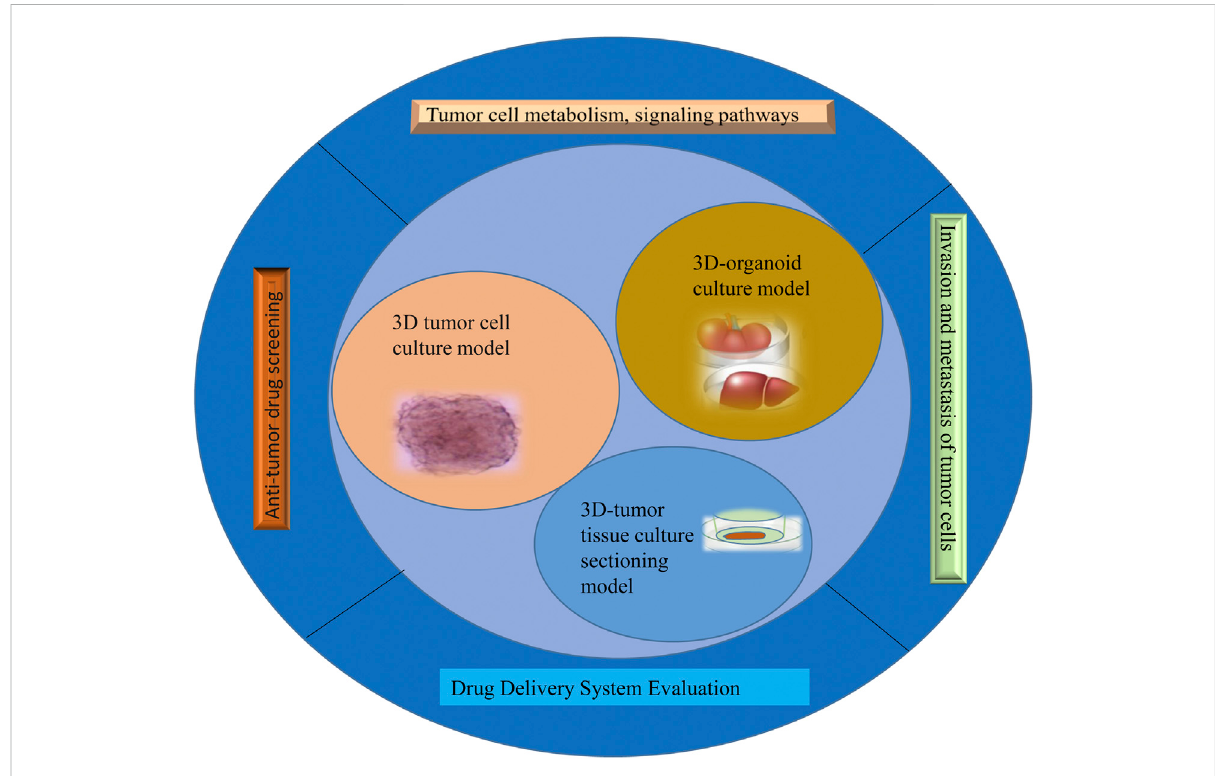
FIGURE 1 Schematic of 3D tumor models in precision oncology and drug